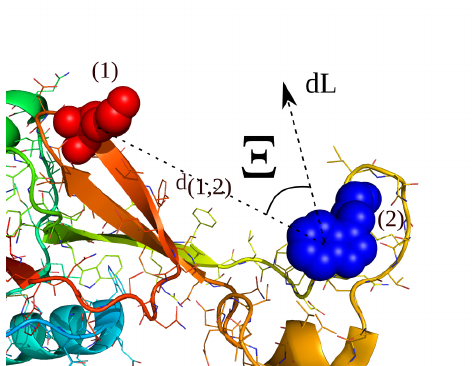
Figure 1. Schematic restraint vector r , an instantaneous path-increment dL and the corresponding angle Ξ , which re-weights the adaptive bias coordinate towards an experimental distance information d 12 between a pair of amino-acids 1 and 2. In this article, we present a method for the coupling of experimental distance restraints along distances between 2 atoms ( d 12 ) and multiple path-dependent biasing increments ∇ H ( B ) . We define a novel restrained biasing Hamiltonian ∇ H ( B ) R as the overlapping fraction of the path-dependent bias in the dynamical trajectory space with the experimental distance vector. We re-evaluate the un-biased Hamiltonian H ( A ) using a renormalization technique, which leads to an accelerating hybrid Hamiltonian H ( C )